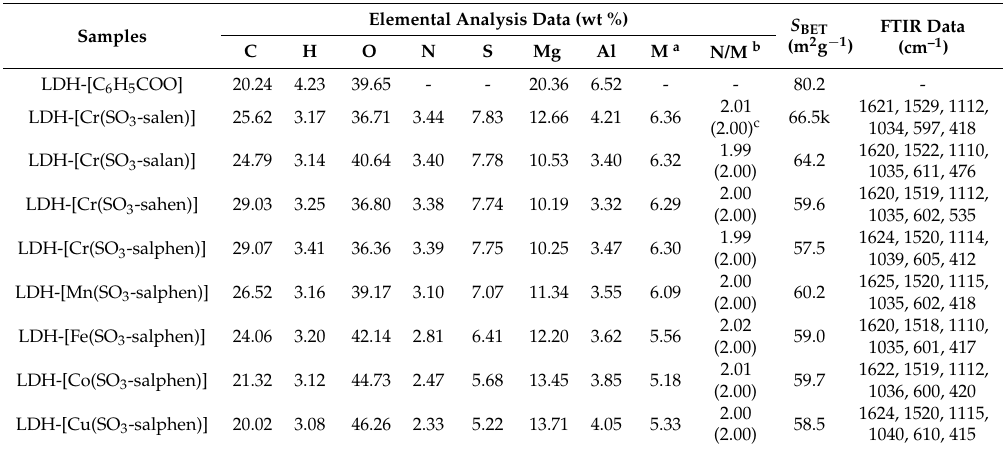
Table 1. Components, textural parameters and spectroscopic data of catalysts. Samples